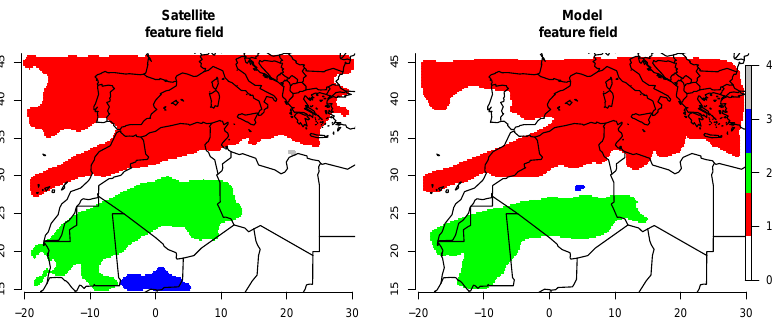
Figure 3. Best matching pairs of entities identified using the MODE method: red and green identify objects that are matched, while dark blue and grey indicates no matching; the x and y axes are longitudes and latitudes, respectively.